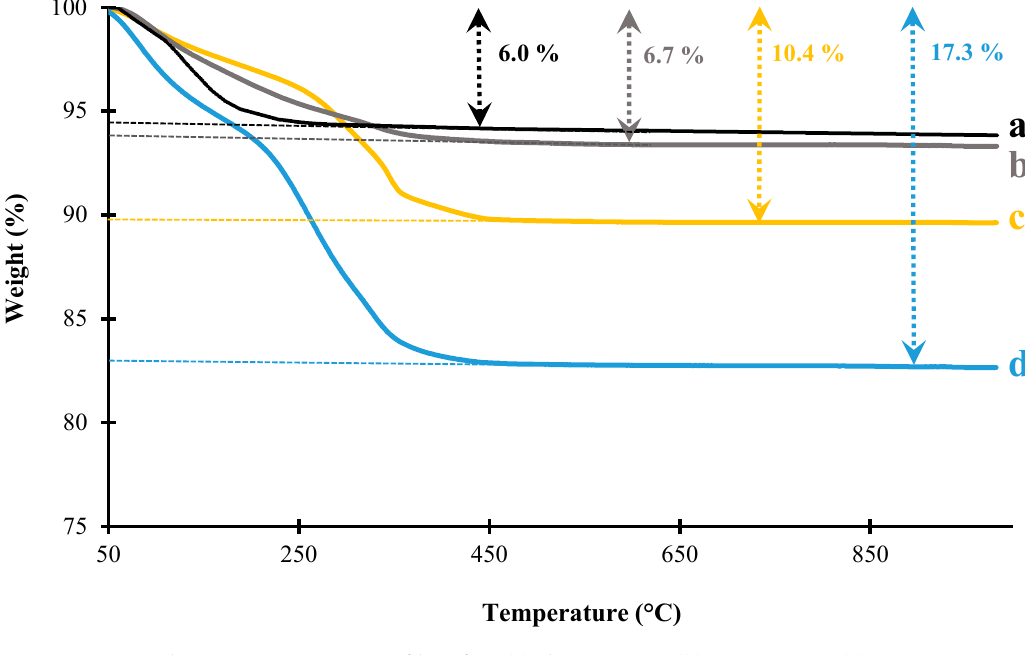
Figure 6. Thermogravimetric profiles for ( a ) bare TiO 2, ( b ) TiO 2 @Au, ( c ) TiO 2 @Au-RB, and ( d ) TiO 2 @Au-HP.